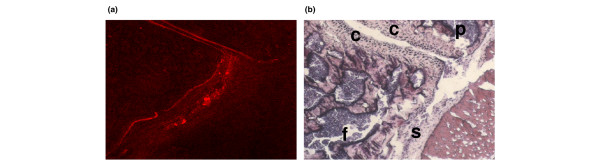
Detection of Texas Red-labelled STAT-1 consensus decoy oligodeoxynucleotide (ODN) after intra-articular administration. (a) Mice were sacrificed 1 h post injection. Internalisation of the labelled STAT-1 decoy ODN as judged by laser scanning microscopy was observed in the synovium region. Untreated control knees did not show any fluorescence signal (not shown). (b) Hematoxylin-eosin stained section of the same region in the knee joint: joint space between patella (p) and femur (f); articular cartilage (c); synovium (s).